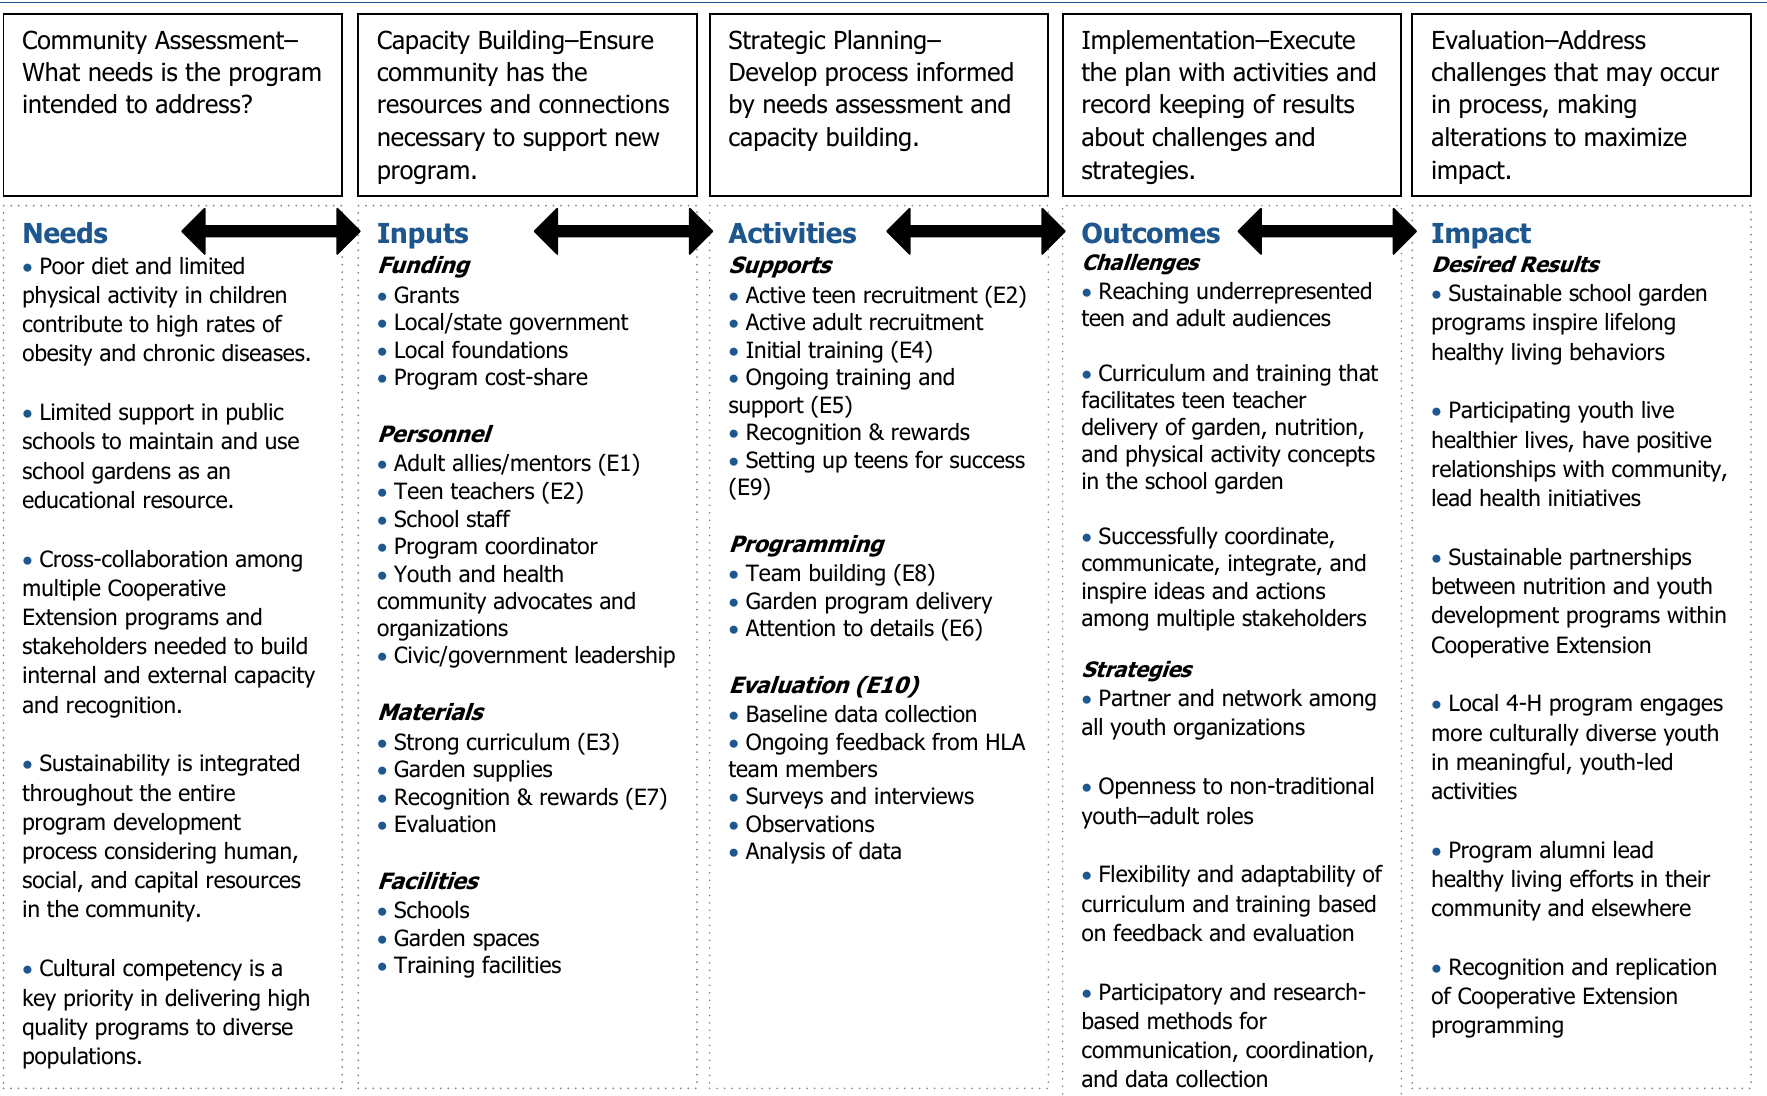
Figure 1. Healthy Living Ambassador Program Logic